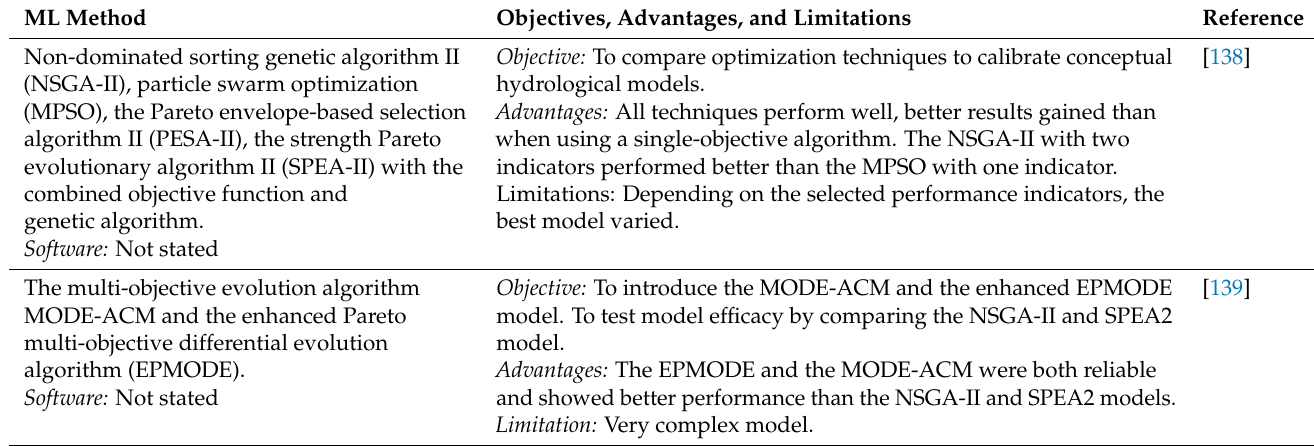
Table 3. Selected GeoAI applications for model calibration and decision support